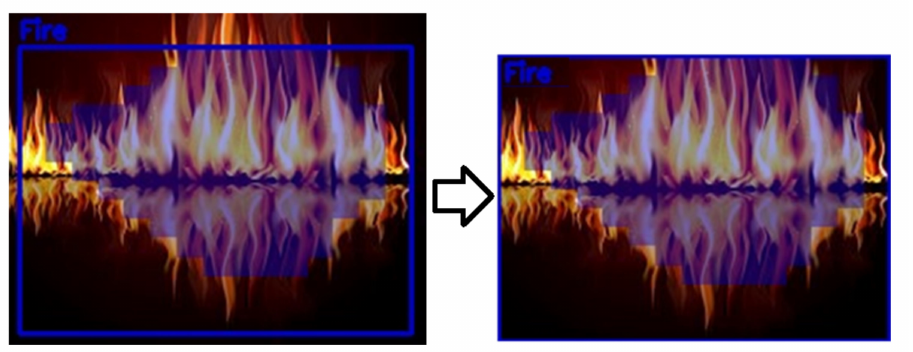
Figure 4. Dominant fire source image and flame